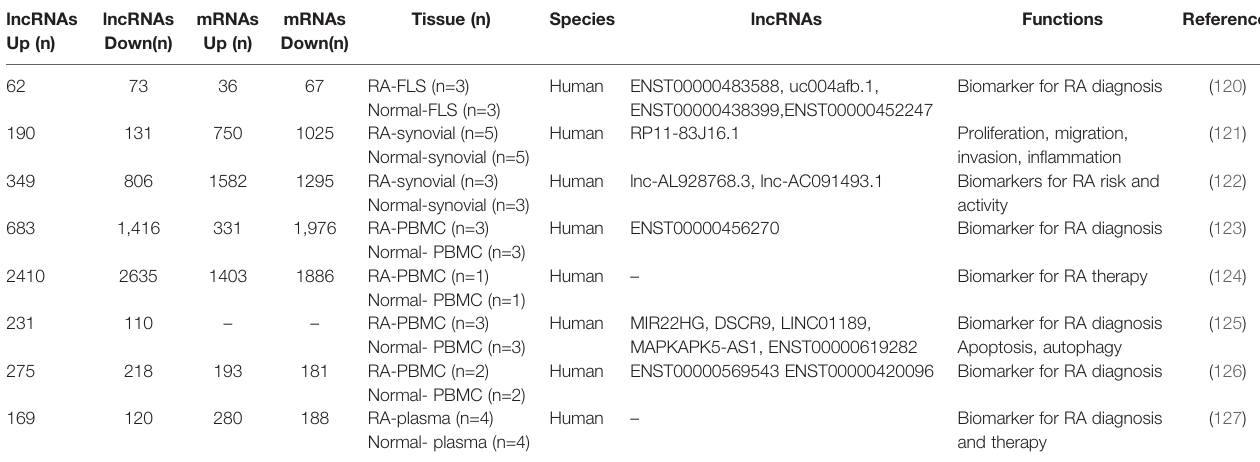
TABLE 2 | The role of lncRNAs in gene expression pro fi les of